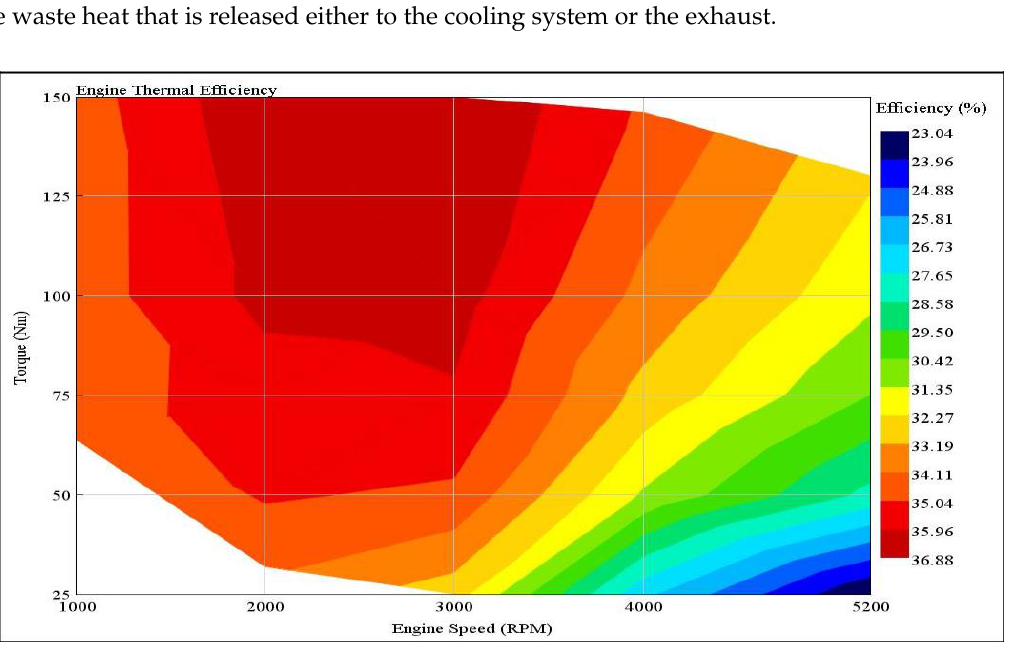
Figure 8. Engine thermal efficiency.